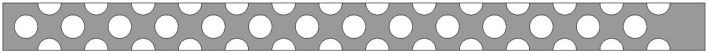
Sketch of the symmetric permeable array of cylinders. The length scales used are Φ = 2.5 mm for each particle diameter and H = 2Φ for the geometry height. The porosity is 0.633.